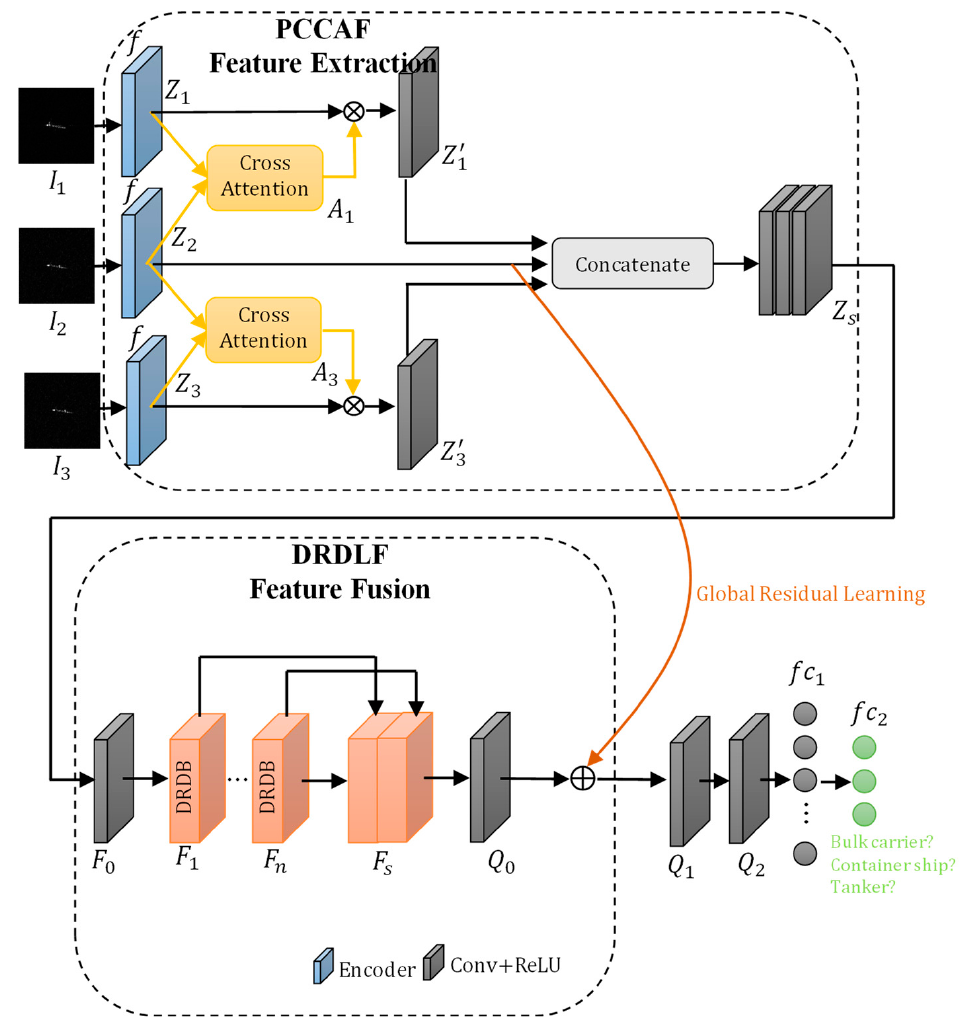
Figure 1. Network architecture of DPIG-Net. PCCAF denotes the polarization channel cross-attention framework. DRDLF denotes the dilated residual dense learning framework. DRDB denotes the dilated residual dense block.